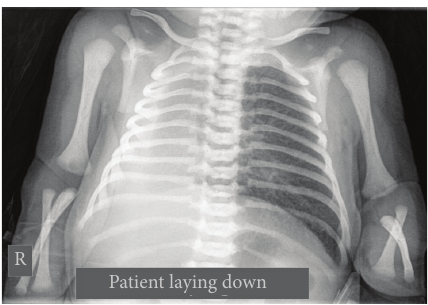
Figure 1: Opaque right hemithorax and left lung hyperinflation.